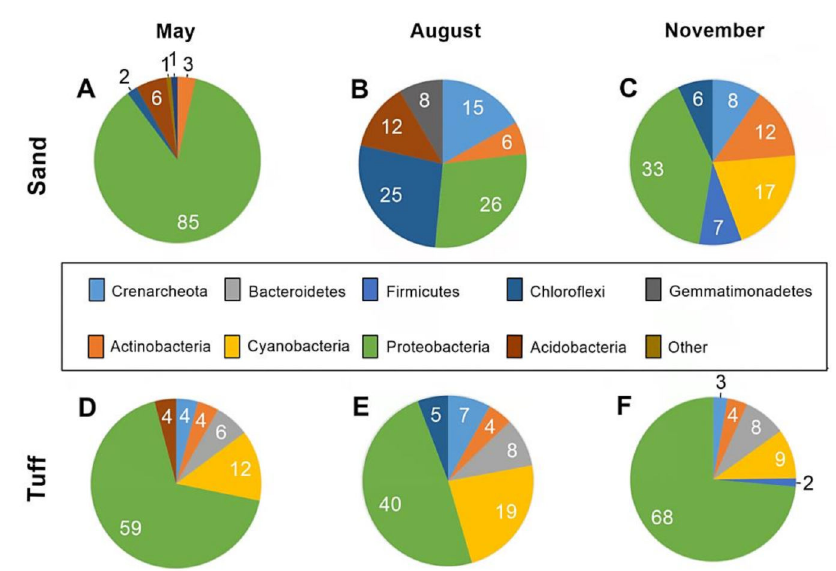
Figure 4. Community structures of the six most abundant phyla that constituted the biofilms associated with the sand and the tu ff grains, during the three sampling periods. Analysis in community structure during the di ff erent sampling months collected from the sand ( A – C ) and tu ff ( D – F ). All the numbers represent the percent operational taxonomic units (OTU) out of the total